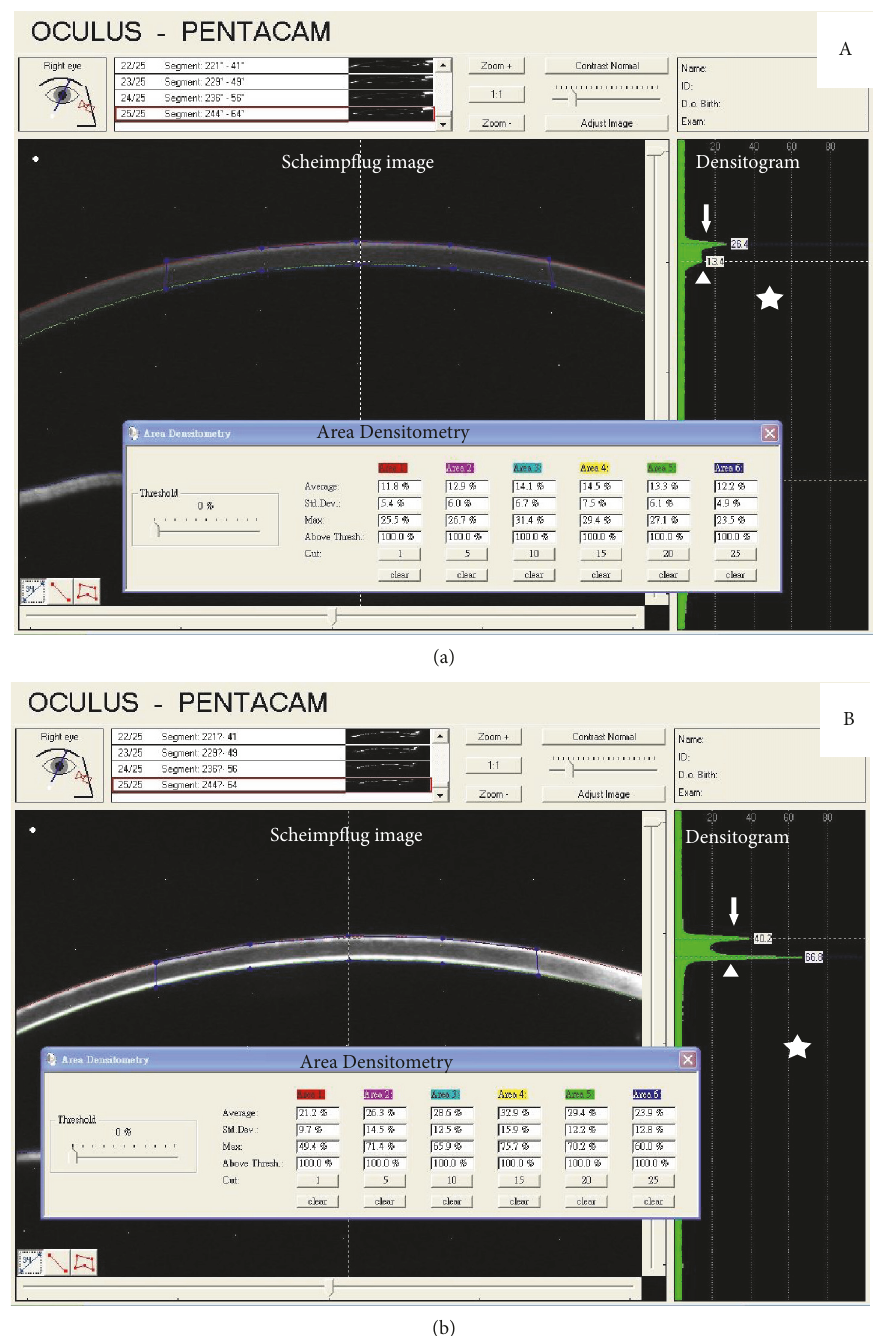
Figure 1: Densitometry of Pentacam Scheimp fl ug images. (a) One spiking hump with central fl attening and a smoothing second hump appear as a high-back chair in normal subjects. (b) Two spiking humps look like a hanging hammock in FECD